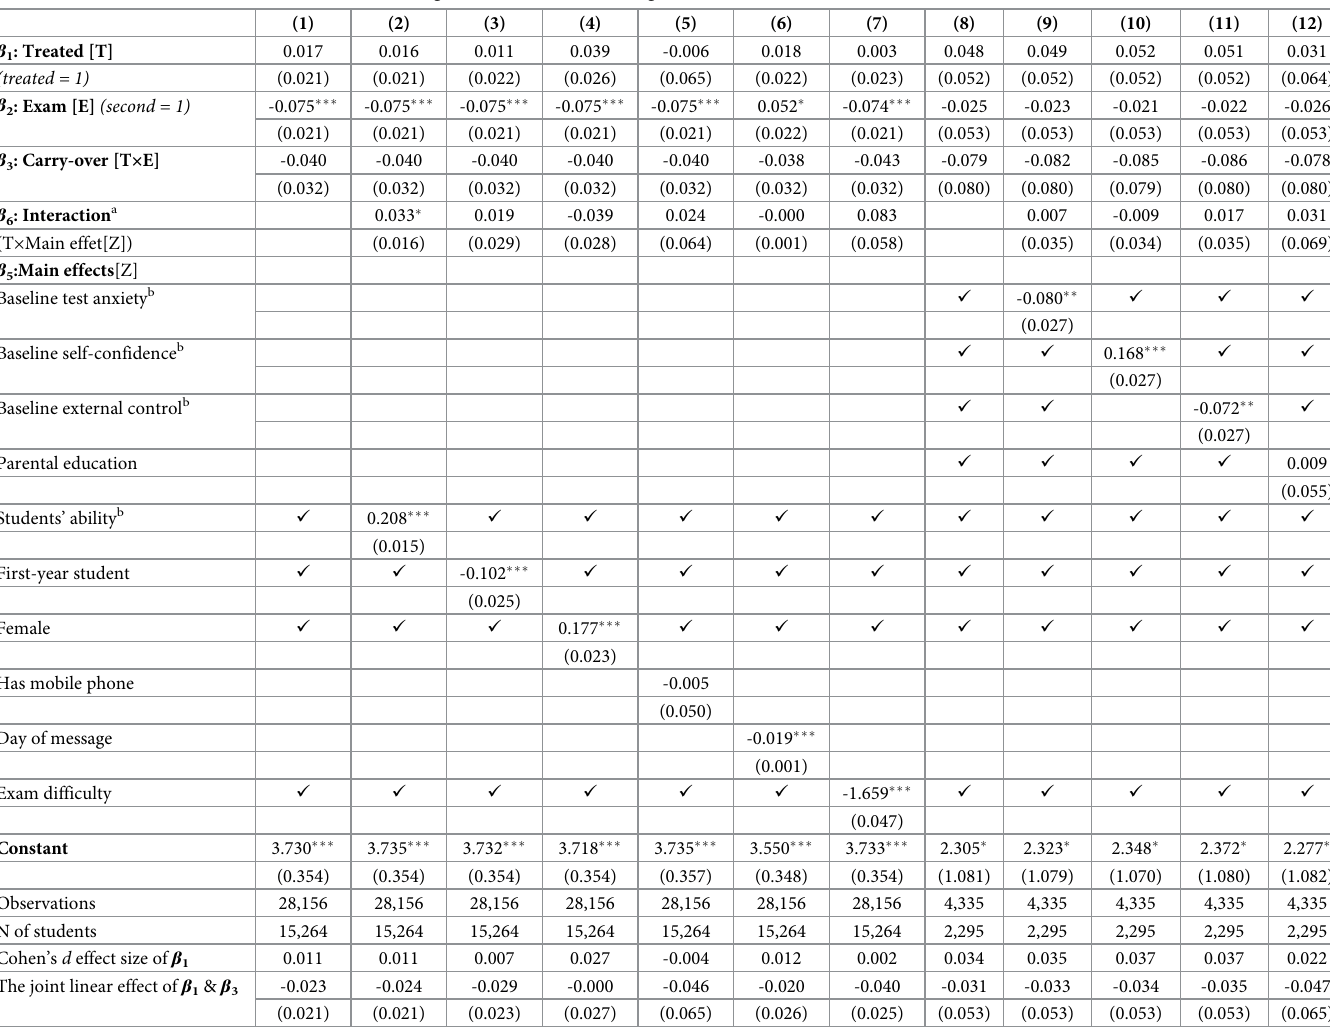
Table 2. Treatment effect on students’ endline exam grades, unstandardized regression